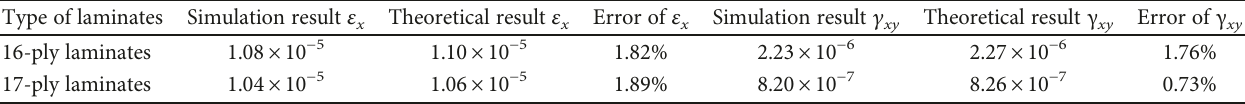
B D F 0 S laminates on extension-shear